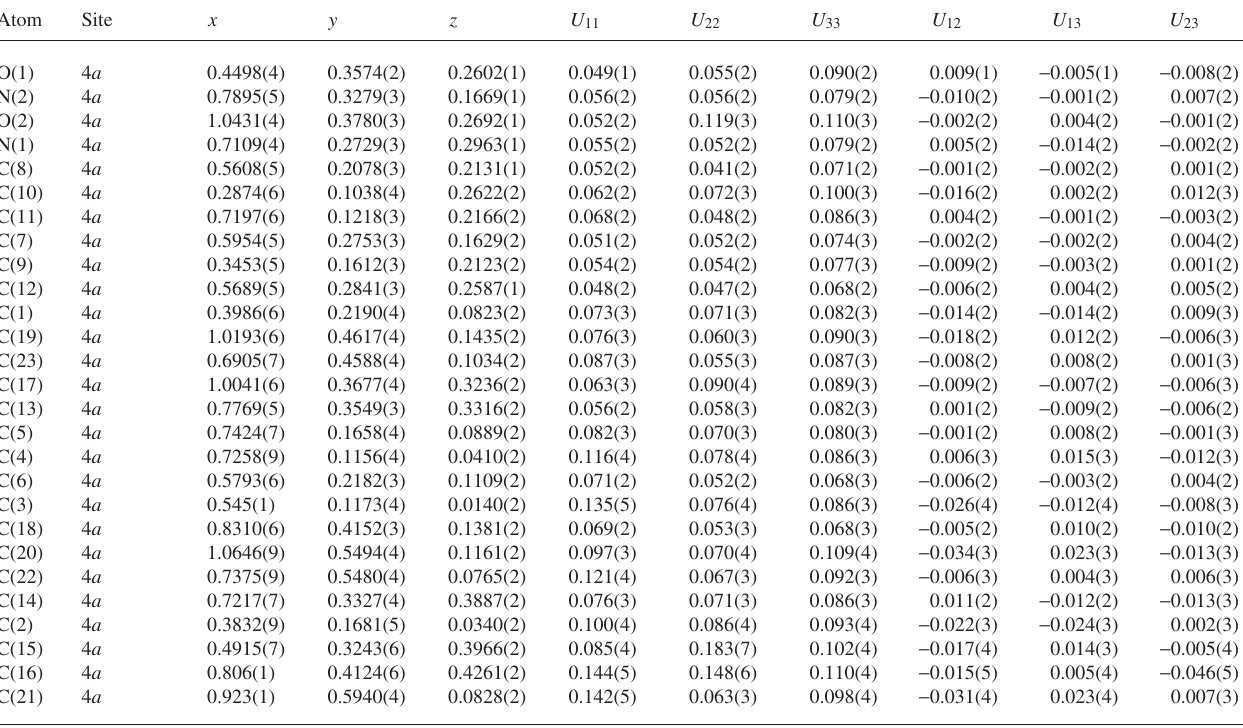
Table 3. Atomic coordinates and displacement parameters (in Å 2 ) .